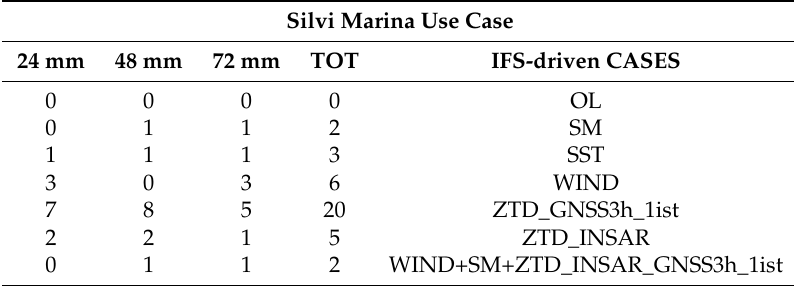
Table A11. Summary of the sensitivity performances (IFS-driven cases). The times in which each forecast has the best result for each score is counted for each threshold and summarized in a total count (summing Tables A7–A9) that is used to find the best